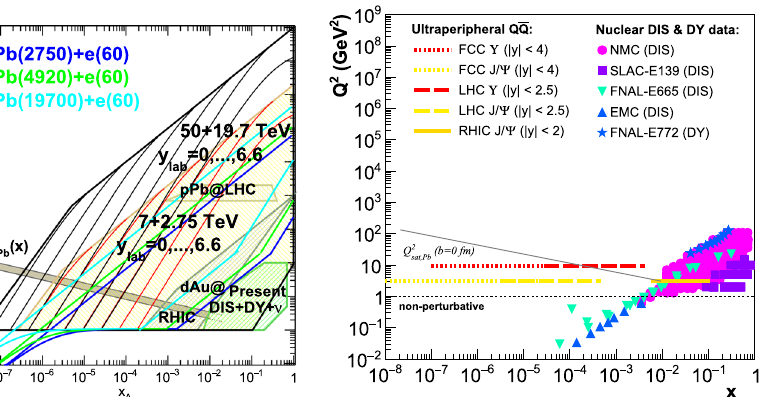
Fig. 16.6 Regions of the x − Q 2 plane covered with nuclear DIS and Drell–Yan data and with p–A and e–A collisions at RHIC, LHC, HE- LHC and FCC (left) and exclusive quarkonium photoproduction in γ –A collisions(right).Forp–AattheLHCandtheFCC,thinlinescorrespond